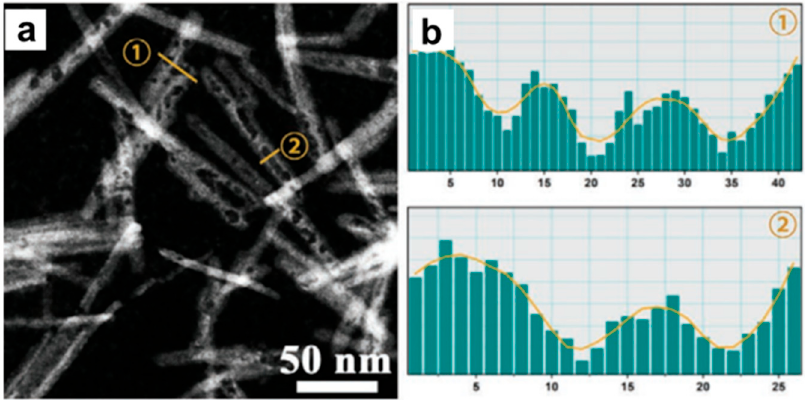
Figure 5. Structural characterization of volume defects in Cu nanoribbons. ( a ) HAADF–STEM im- ages. ( b ) The corresponding intensity profile along the lines that marked by numbers 1 and 2 with yellow color in ( a ). Reproduced with permission [57]. Copyright 2021, Wiley–VCH.